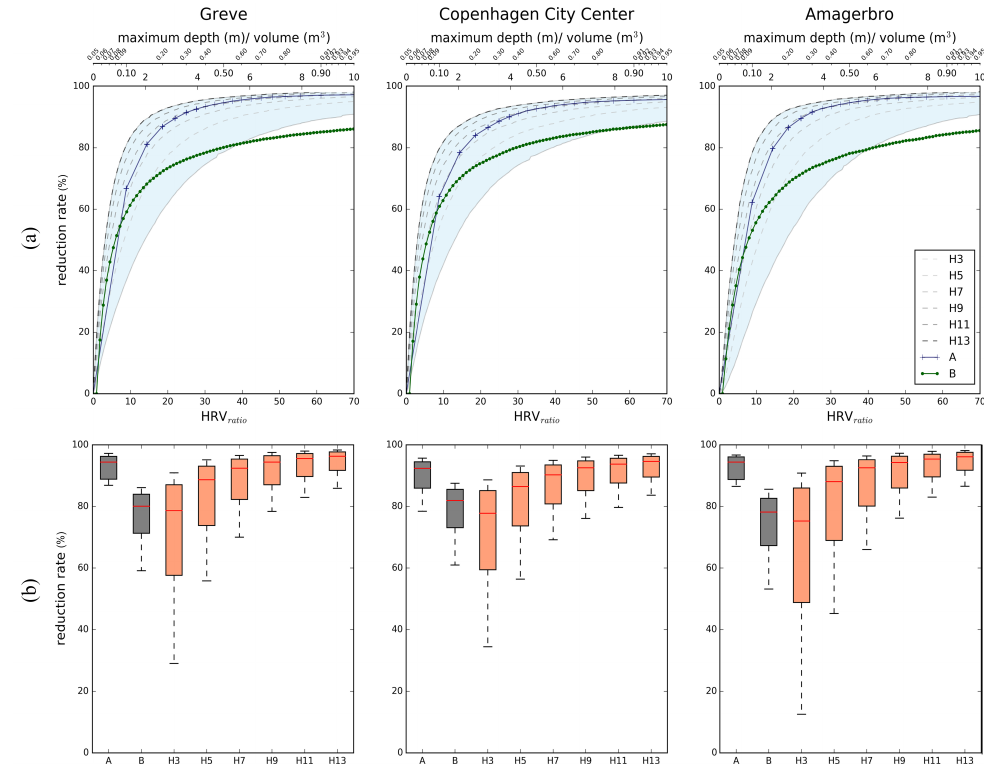
Figure 3. ( a ) Curves for sink reduction rate. The upper two x-axes represent the maximum depth and the volume; the lower x-axis stands for HRV ratio . ( b ) Boxplots for the distribution of sink reduction rate. A and B belong to the geometry-based screening, with maximum depth and volume threshold values shown as grey boxes. H3–H13 belong to the HRV ratio computed based on six accumulated rainfalls of 30–130 mm with threshold values shown as orange boxes. The upper and lower ends of the bars represent maximum and minimum value of sink reduction rate; the upper and lower ends of the boxes represent third quartile (0.25) and first quartile (0.75); the red lines represent the median value. Note: A = maximum depth; B = volume; HR = HVR Radar ; H3 = HVR 30 mm ; H5 = HVR 50 mm ; ratio ratio ratio H7 = HVR 70 mm ; H9 = HVR 90 mm ; H11 = HVR 110 mm ; H13 = HVR 130 mm ratio ratio ratio ratio